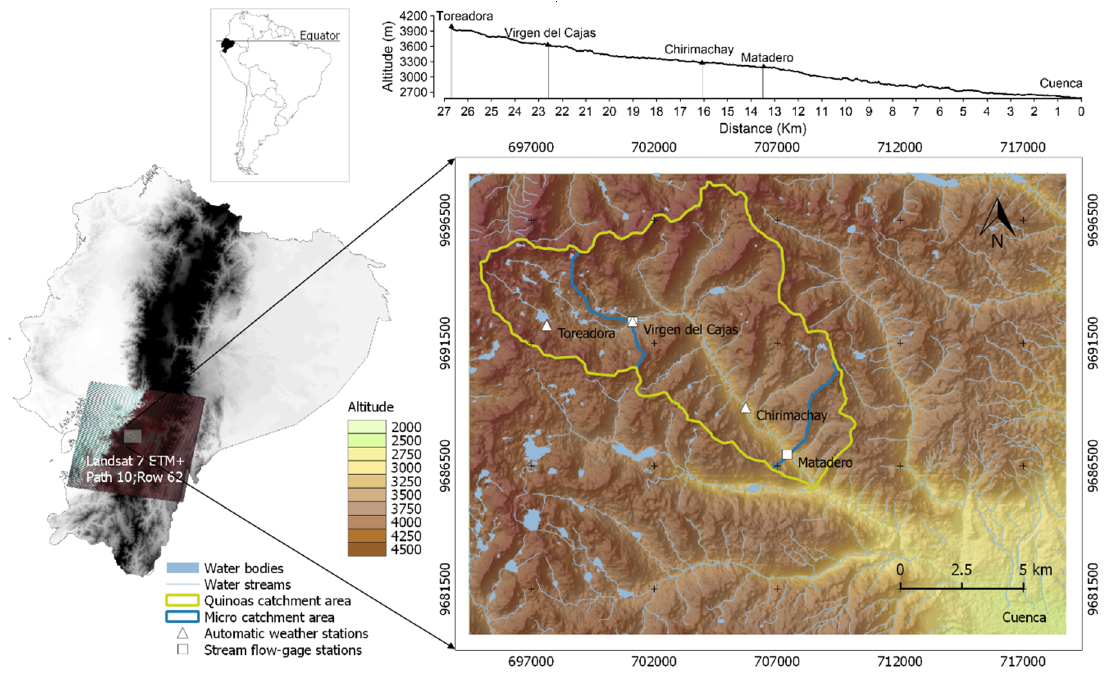
Figure 1. Study area and the quinoas catchment.